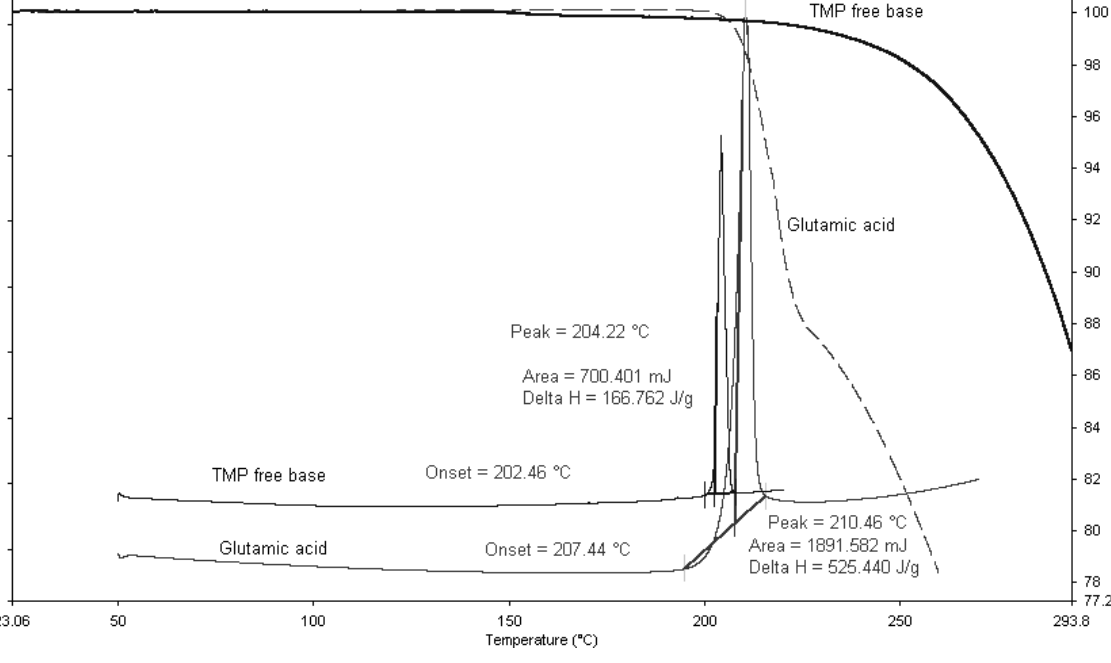
Figure 5. Thermogravimetric analysis (TGA) and Differential Scanning Calorimetry (DSC) scans for L -glutamic acid and TMP free base.